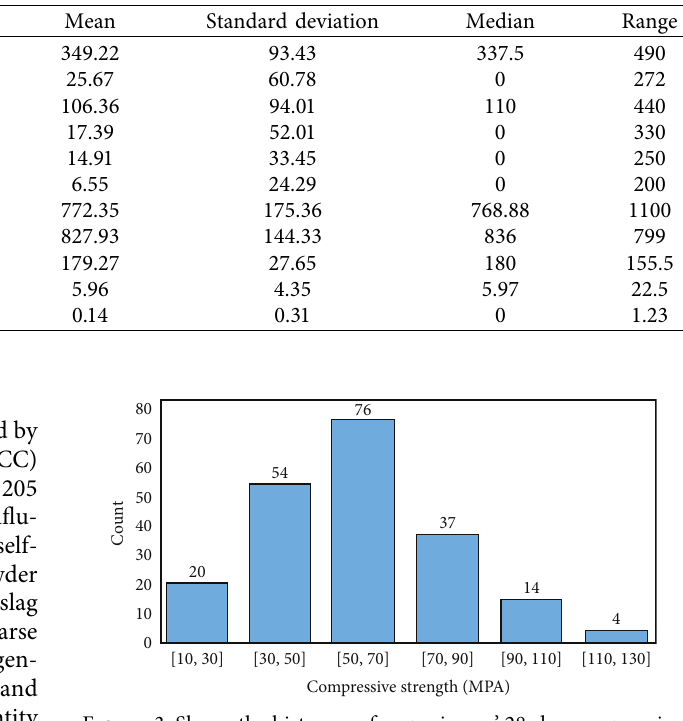
Table 1: Descriptive attributes of the collected dataset.